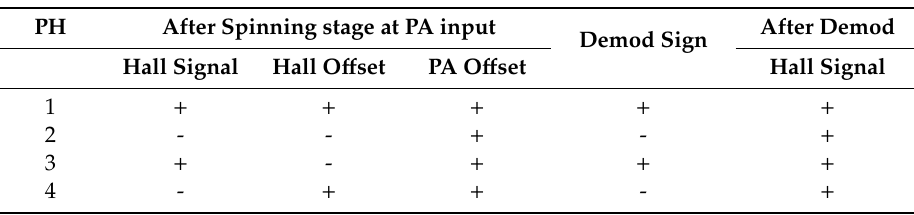
Figure 5. The two top graphs show the output response of the amplification stage with the offset superimposed on the true Hall voltage. The demodulation key shown in red applied on the top graphs produces the differential true Hall voltage output upon low pass filtering. Table 2. Demodulation key applied on the amplified spinning output for the extraction of the true Hall voltage. PA: pre-amplifier.